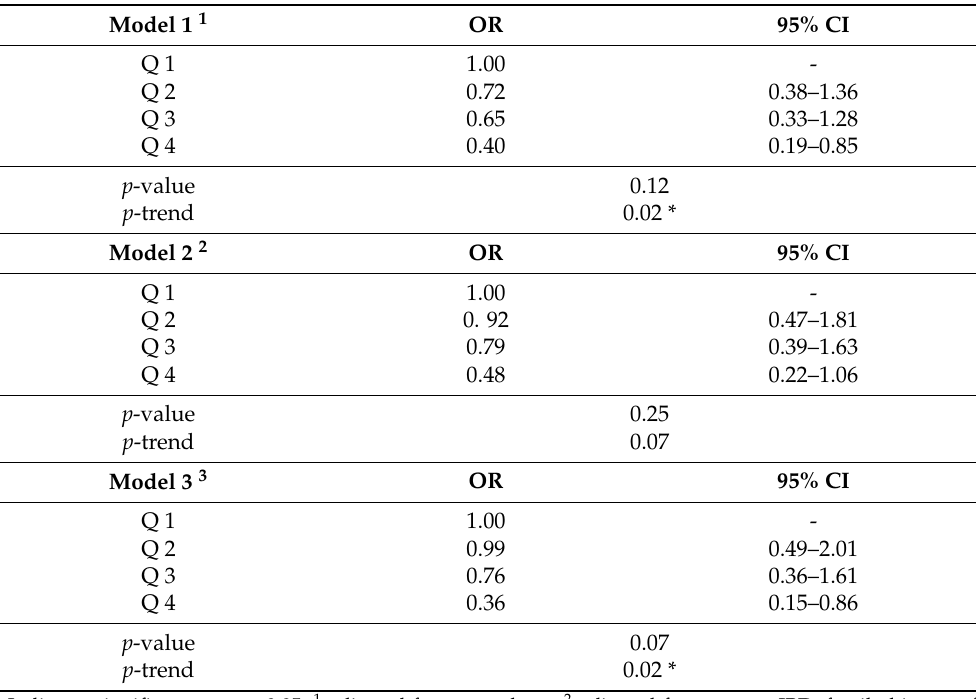
Table 3. Odds ratios and 95% confidence intervals between fiber intake and colorectal cancer risk (N = 528; cases: (N = 118), controls (N = 410)).